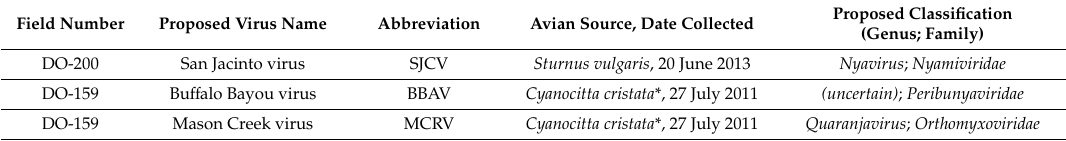
Table 1. Summary of tree novel viruses isolated from brains of dead birds in Harris County,